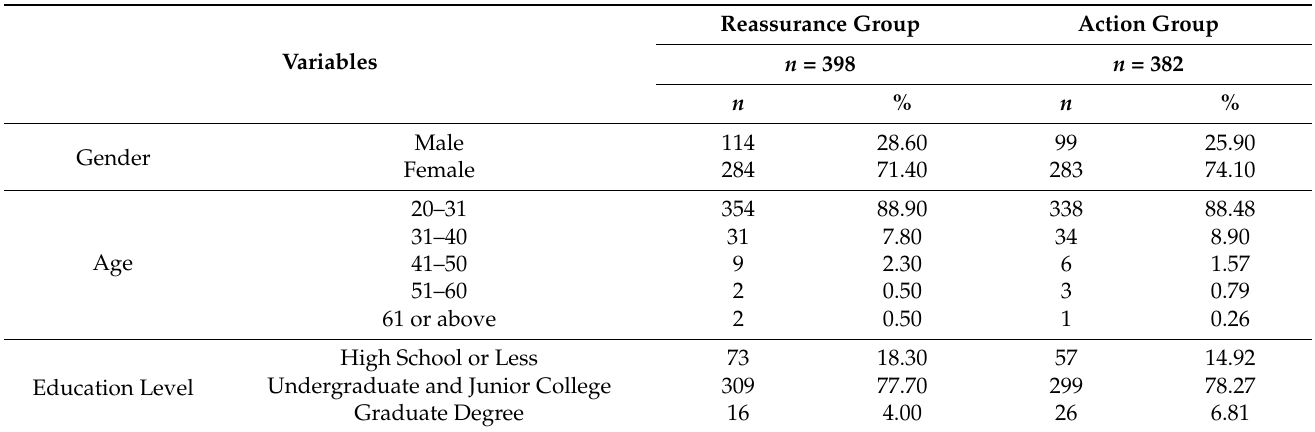
Table 2. Descriptive statistics of respondents’